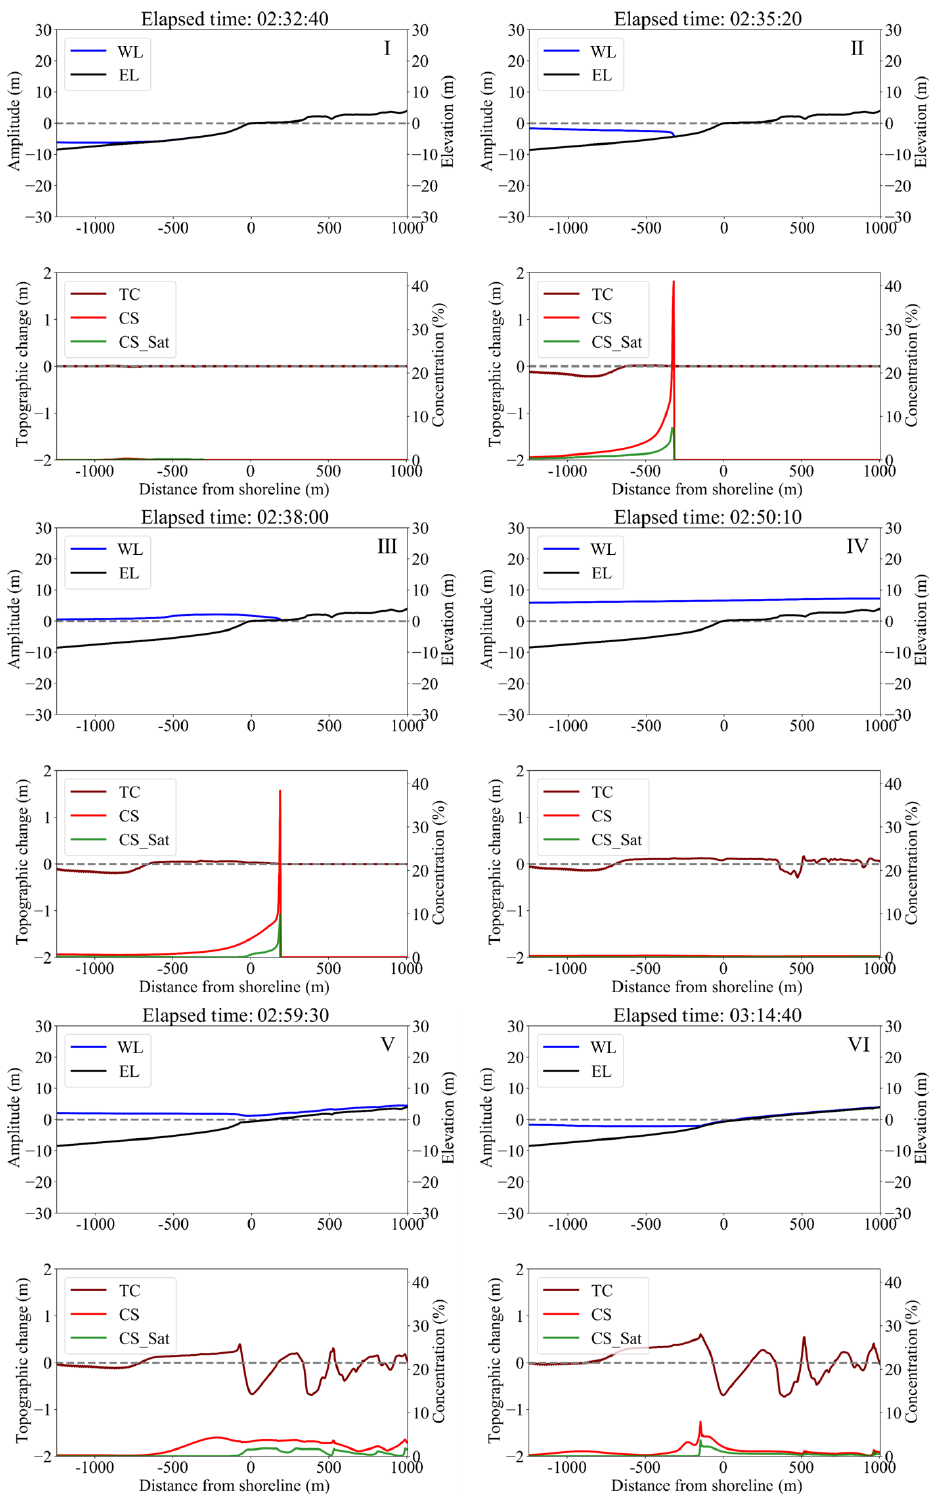
Figure 14. Change in water level (WL), land surface (EL), topographic change (TC), suspended sediment concentration (CS) and saturation suspended sediment concentration (CS_Sat) by section calculation along the survey line in region (b). (I) before the first inflowing wave, (II) Advance of first leading wave in shallow water. (III) Start of first leading wave run-up. (IV) Maximum of first leading wave. (V) Advance of second backwash. (VI) Maximum of second